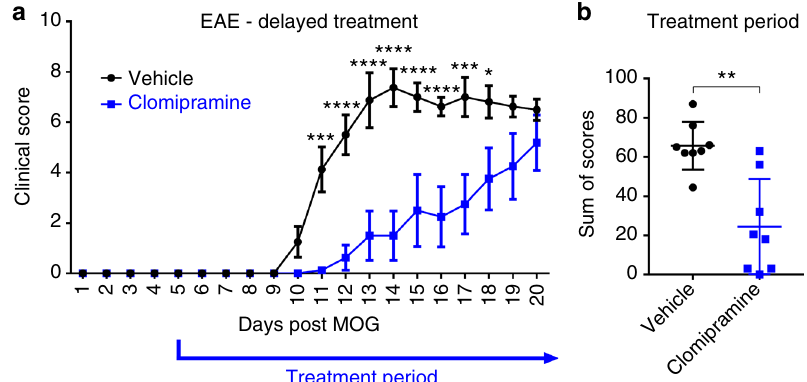
Fig. 7 Clomipramine initiated from day 5 delays the onset of EAE clinical disease. Female C57BL/6 mice (age 8 – 10 weeks) were treated with clomipramine IP (25 mg/kg) or PBS (vehicle) from day 5 after induction of MOG-EAE ( a ). The disease onset was delayed and from day 11 the clinical course differed signi fi cantly ( p < 0.001). Eventually, clomipramine-treated mice also developed the same disease burden as vehicle-treated mice. The overall disease burden is shown in ( b ). n = 8 vehicle and n = 8 clomipramine EAE mice. Data are depicted as mean ± SEM. Two-way ANOVA with Sidak's multiple- comparisons test as post hoc analysis ( a ) and two-tailed unpaired non-parametric Mann – Whitney test ( b ). Signi fi cance is shown as * p < 0.05; ** p < 0.01; *** p < 0.001; **** p <